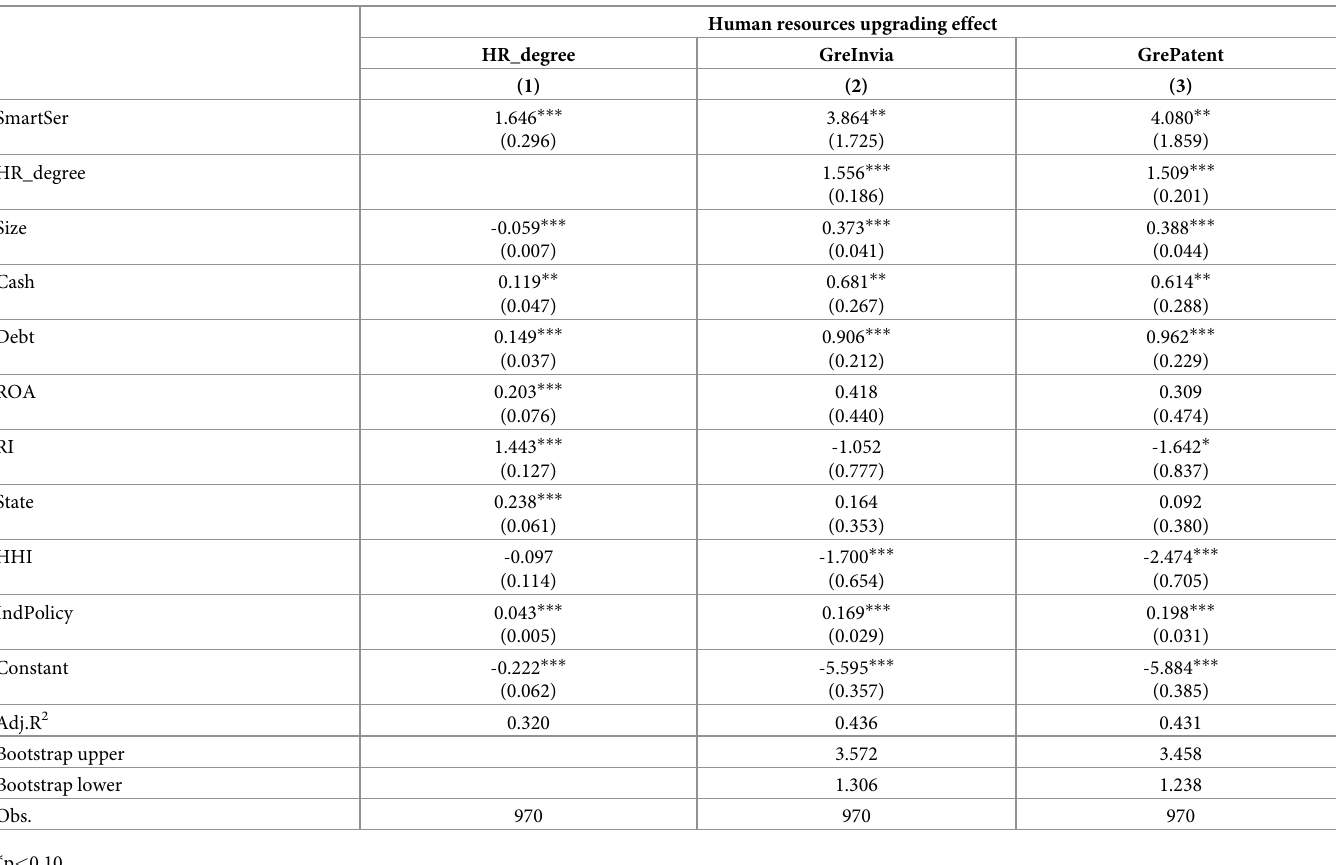
Table 8. Test results of mediating mechanism (2).